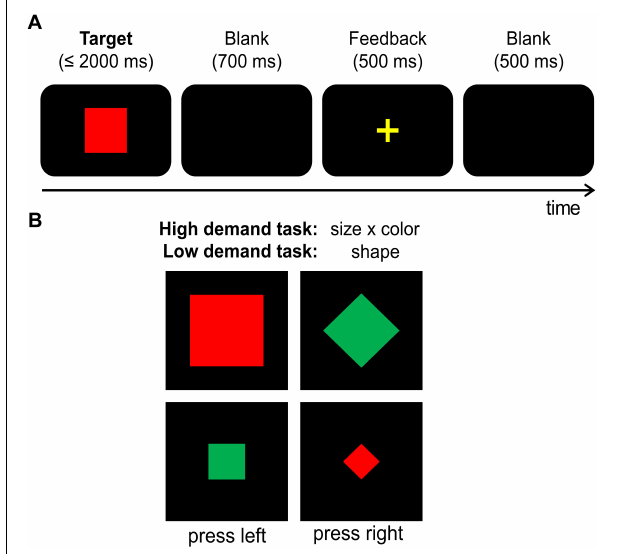
FIGURE 1 | (A) Illustration of the task. Each trial started with the target presentation, which was either terminated by the first response or after 2000 ms had elapsed (in this case, the trial was coded as a “miss”). The target was followed by a 700 ms blank screen, a 500 ms feedback (“+” for correct and “–” for incorrect or missed responses) and a second 500 ms blank screen. (B) Illustration of employed target stimuli. Targets could vary in shape (square vs. diamond), size (small vs. large) and color (green vs. red). Please note that those are examples and not all of the employed stimulus combinations are illustrated here. The easy task required left button presses for squares and right button presses for diamonds. The hard task required left button presses for targets that were either large and red OR small and green while right button presses were required for targets that were either large and green OR small and red. Hence, the two exemplary stimuli on the left of this graph required a left hand response while the two stimuli on the right on the graph required a right hand response in both of the